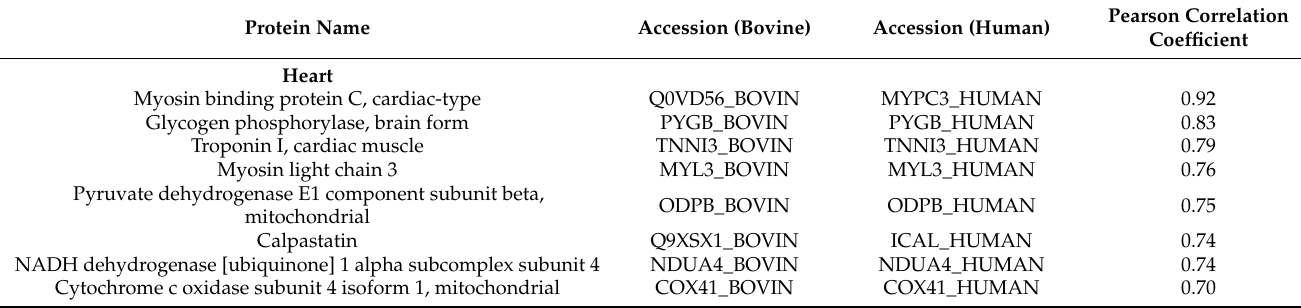
Table 4. Highly discriminating protein identifications per organ (top